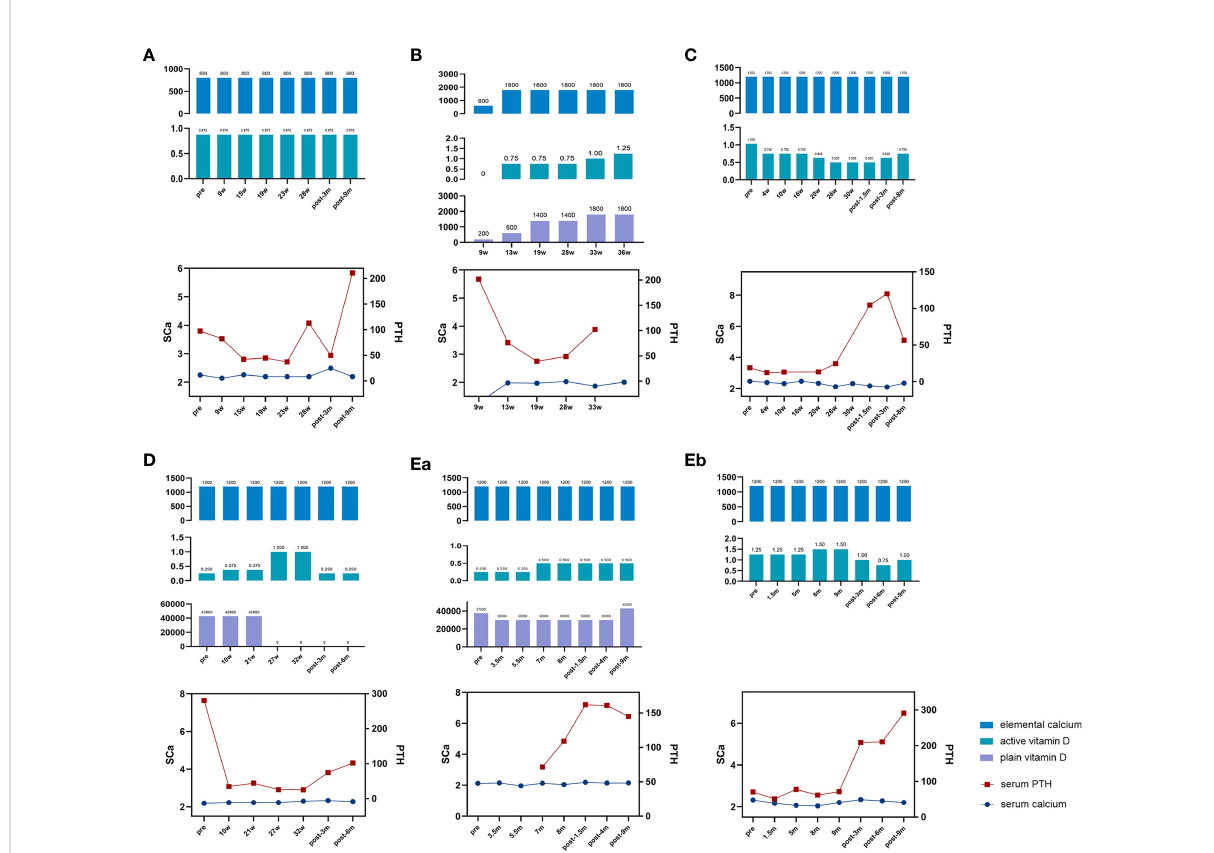
FIGURE 1 Changes in biochemical indices and medicine dosage of the patients. Elemental calcium (mg); active vitamin D, calcitriol ( m g); plain vitamin D, calciferol/cholecalciferol (IU); serum PTH, serum parathyroid hormone level (ng/ml); SCa, serum calcium level (mmol/L); pre, prepregnancy; w, gestation week; post, postpregnancy; m, month after delivery. (A) Drug dosage, serum calcium, and PTH level of patient 1. (B) Drug dosage, serum calcium, and PTH level of patient 2. (C) Drug dosage, serum calcium, and PTH level of patient 3. (D) Drug dosage, serum calcium, and PTH level of patient 4. (Ea) Drug dosage, serum calcium, and PTH level of patient 5 ’ s fi rst pregnancy. (Eb) Drug dosage, serum calcium, and PTH level of patient 5 ’ s third